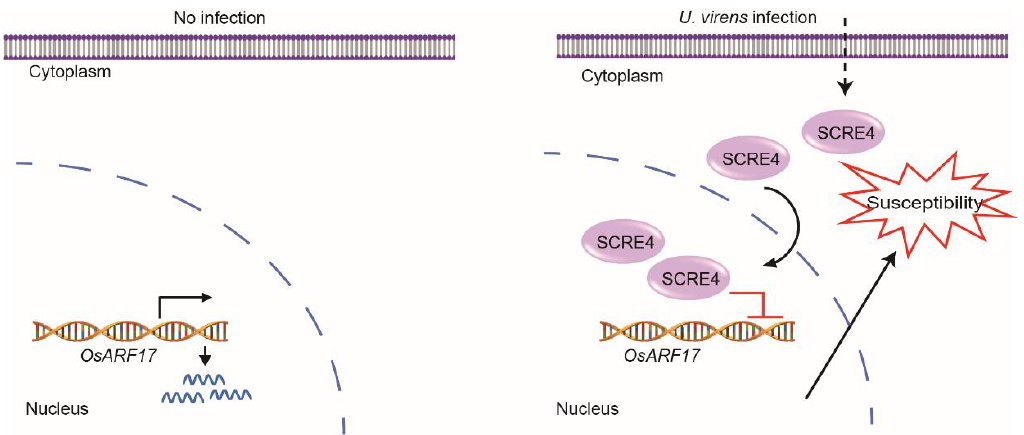
Figure 7. A working model of SCRE4 suppressing rice immunity. The auxin response factor OsARF17 functions as a positive regulator of PTI responses and positively regulates rice resistance to false smut. During U. virens infection, the essential virulence effector SCRE4 is secreted and translocated into rice nuclei. Through an unidentified mechanism, SCRE4 transcriptionally suppresses OsARF17 expression in the nucleus and subsequently inhibits MAPK activation and ROS production. Therefore, immune responses in rice are disarmed, thus promoting U. virens infection.